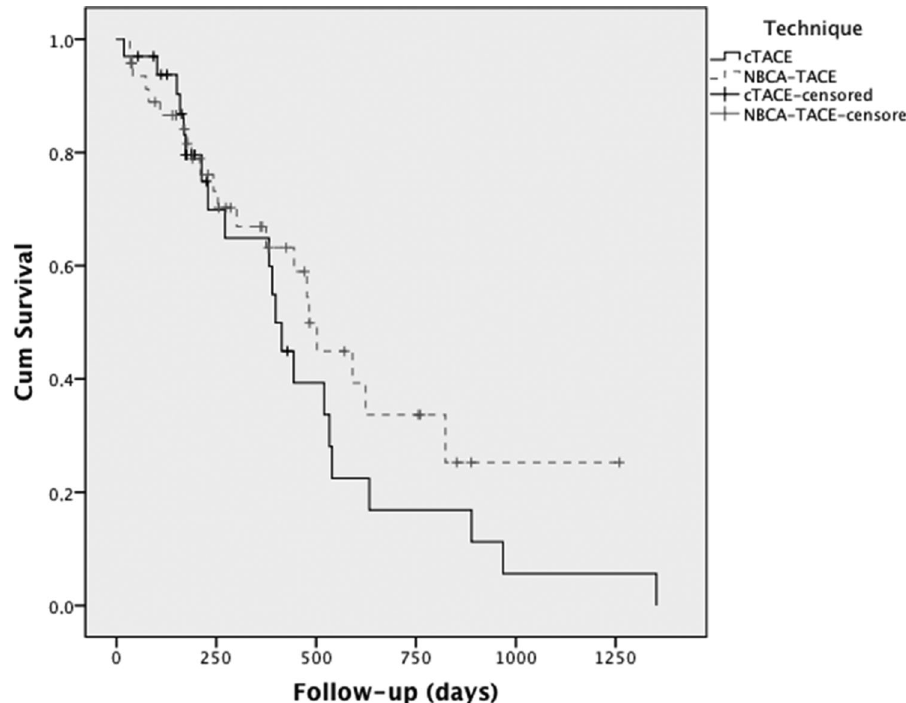
Figure 5 - Kaplan-Meier curve of OS of patients undergoing cTACE and NBCA-TACE.